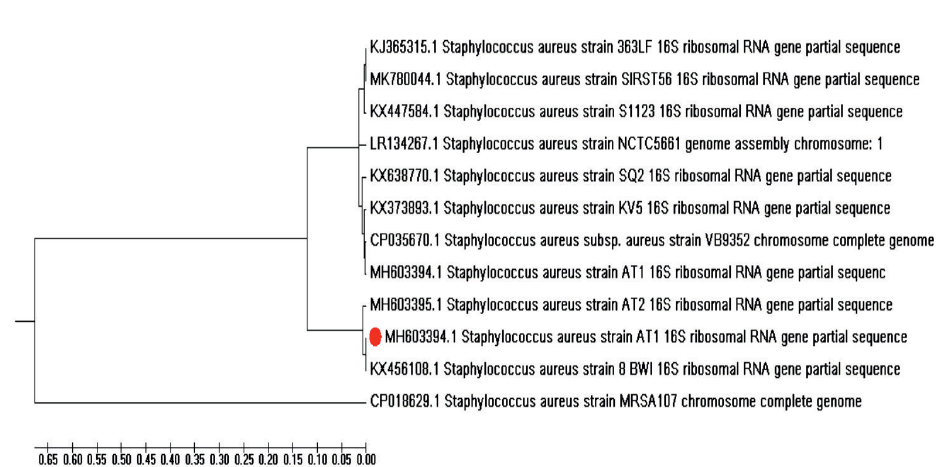
Fig. 6. Evolutionary relationships of taxa. The isolated bacteria with its accession number is indicated by red